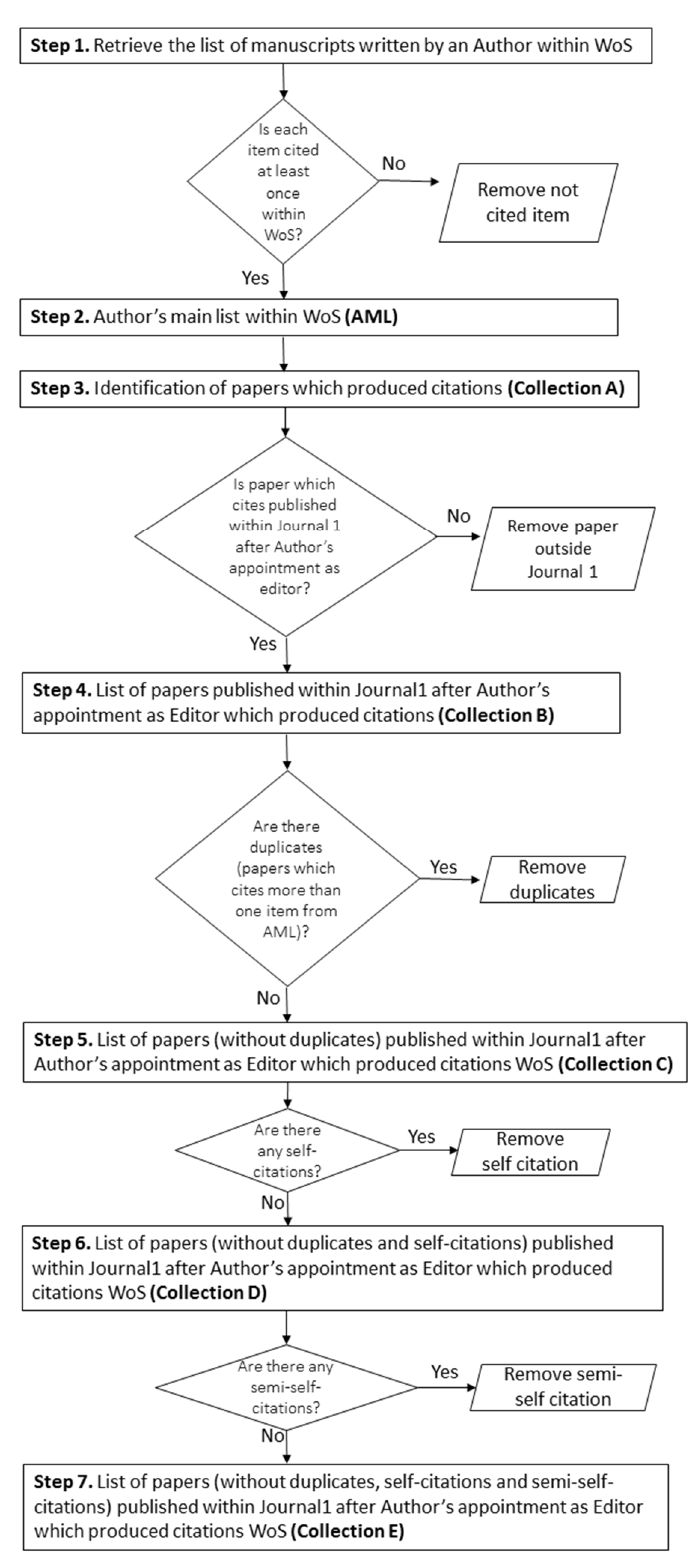
Figure 1. Methodological framework.